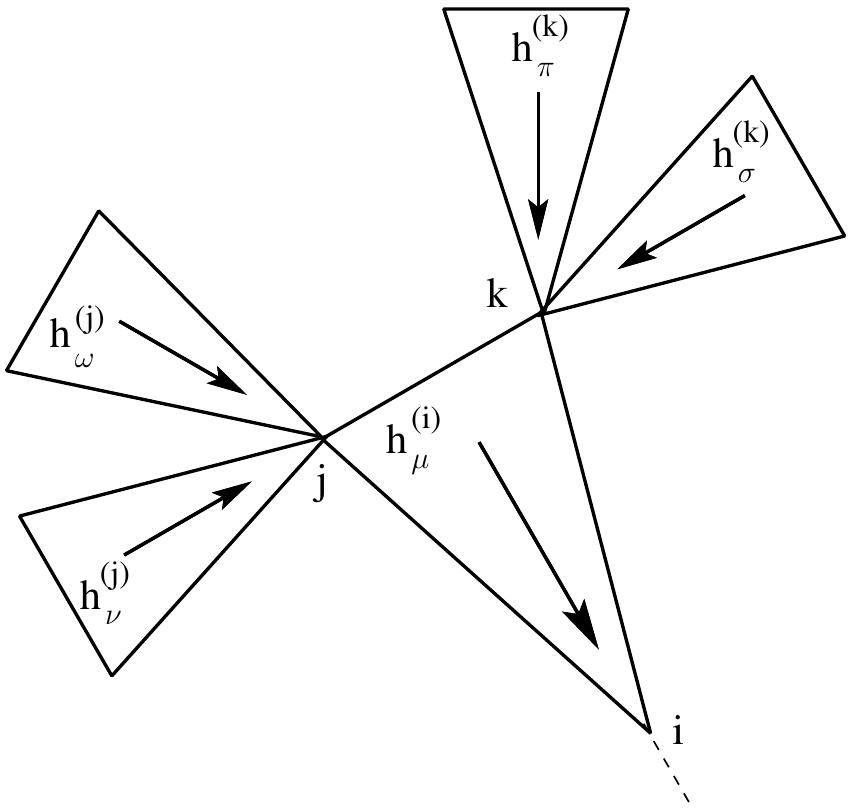
Figure 2: Local structure of the Bethe hyper-lattice for p = c = 3. The cavity fields that satisfy the recursive cavity equation in Eq. (16) are also